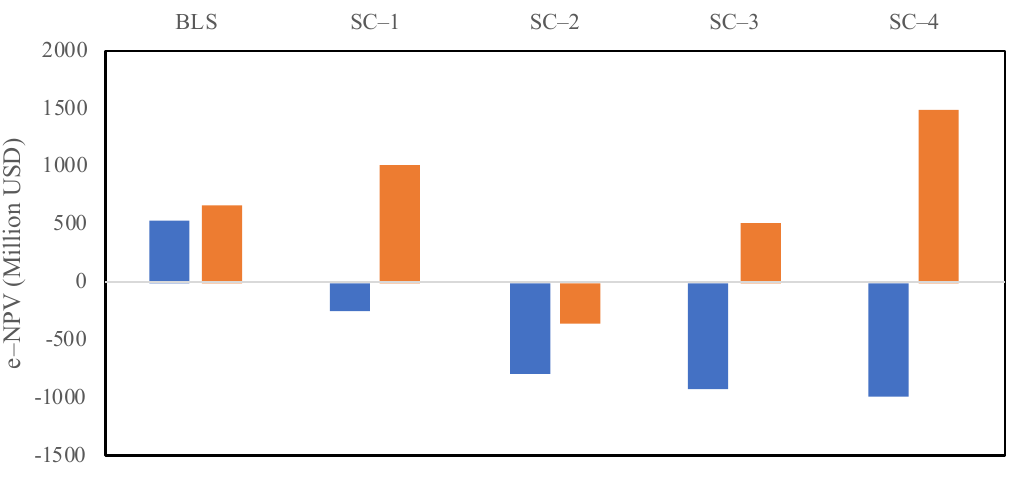
Figure 12. Comparative analysis of extended net present value (e–NPV) using both traditional and ROA approaches.